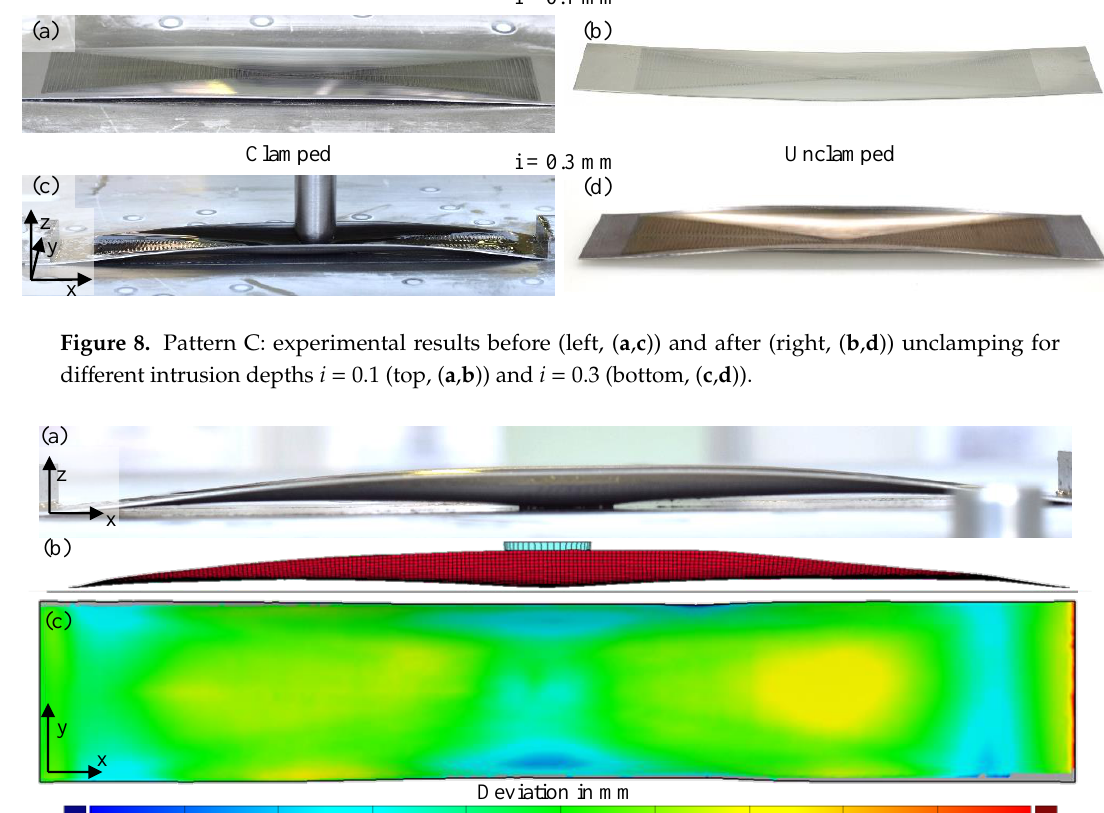
Figure 8. Pattern C: experimental results before (left, ( a ) and ( c )) and after (right, ( b ) and ( d )) unclamping for different intrusion depths i = 0.1 (top, ( a ) and ( b )) and i = 0.3 (bottom, ( c ) and ( d )).